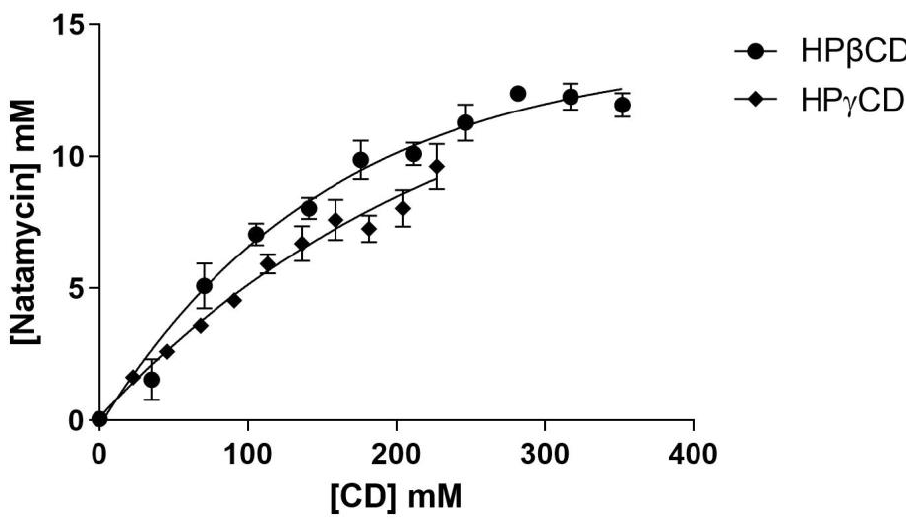
Figure 1. Phase solubility diagrams for natamycin, obtained with 2 different types of cyclodextrin (HPβCD and HPγCD) at 25 °C in water (mean ± SD, n = 6).